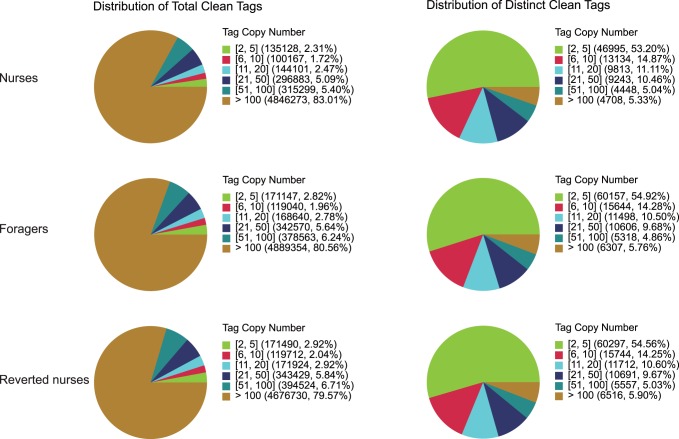
Distribution of total clean tags and distinct clean tags over different tag abundance categories in each sample.Numbers in the square brackets indicate the range of copy numbers for a specific category of tags.